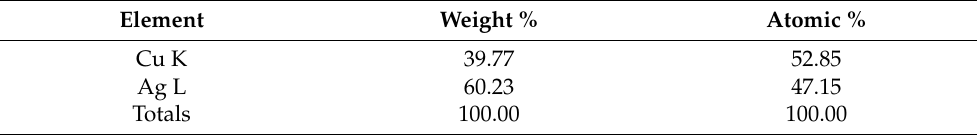
Figure 3. Energy dispersive X-ray (EDX) spectrum of synthesized AgNPs ( A ), FE-TEM image used for elemental mapping ( B ), distribution of silver ( C ), and copper ( D ) in elemental mapping. Table 2. The number and percentage of chemical elements present in EDX spectrum of probiotic- mediated synthesized AgNPs.